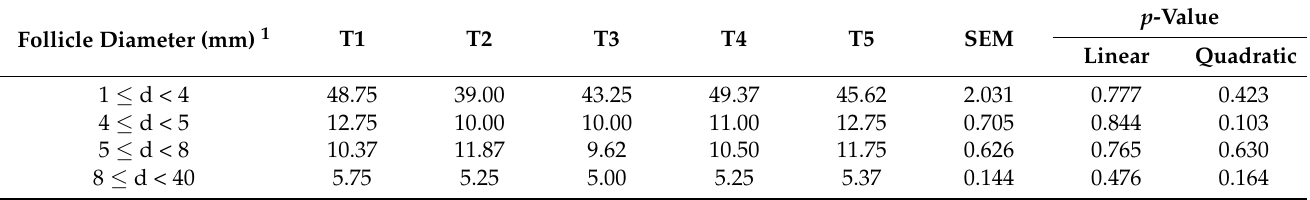
Table 6. Effects of casein phosphopeptide (CPP) on the follicle number of laying